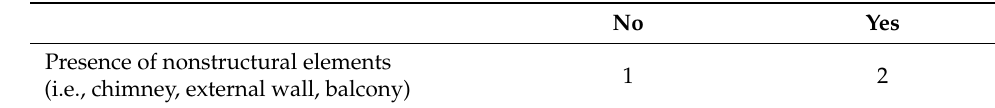
Table 6. Matrix used to complete criterion E (adapted from FEMA-154).